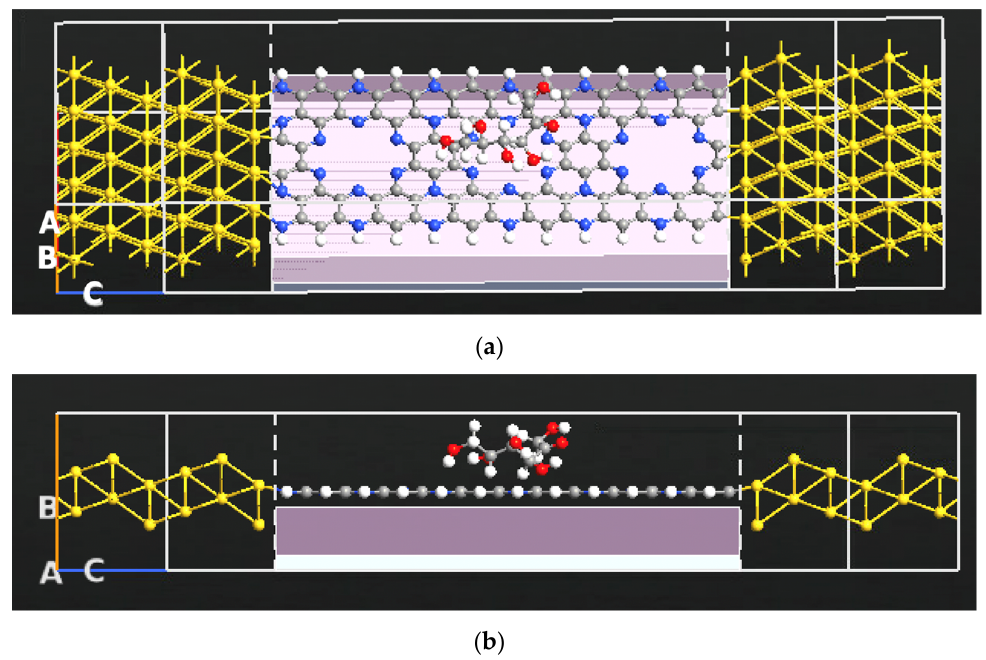
Figure 3. ( a ) Schematic diagram of the C 2 N-FET sensor with fructose. ( b ) Cross-sectional view of the C 2 N-FET sensor with fructose. C 2 N-FET sensor with